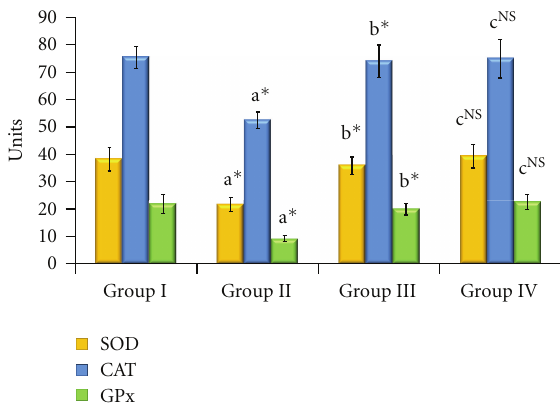
Figure 1: E ff ect of TD on enzymic antioxidants in serum of control and experimental animals. Values are expressed as mean ± SD for six animals. Comparisons are made between “a” Group II versus Group I, “b” Group III versus Group II, “c” Group IV versus Group I. The symbol ∗ represents the statistical significance at P < 0 . 05 NS: nonsignificant. SOD: U/min/mg protein, CAT: µ moles of H 2 O 2 consumed/min/mg protein, GPx: µ moles of GSH oxidized/min/mg protein.